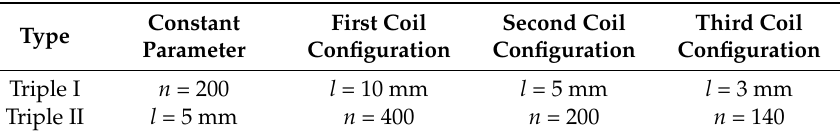
Figure 2. Air coil sensor structure with its design specification. Table 1. Type of coil configuration for triple series flat-type air coil sensor.